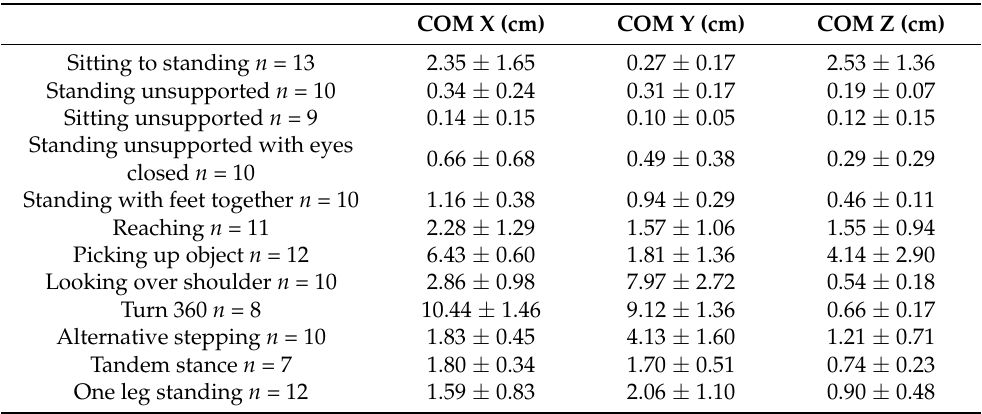
Table 2. Representing root mean square error between the HTC Vive tracker and the COM in X, Y, and Z direction for the 12 BBS